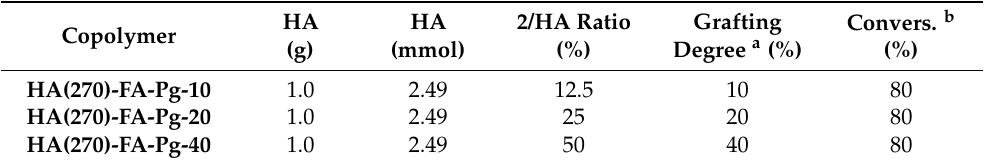
Table 1. Reaction parameters in the grafting of HA(270) to HA(270)-FA-Pg graft copolymers with imidazolide derivative 2